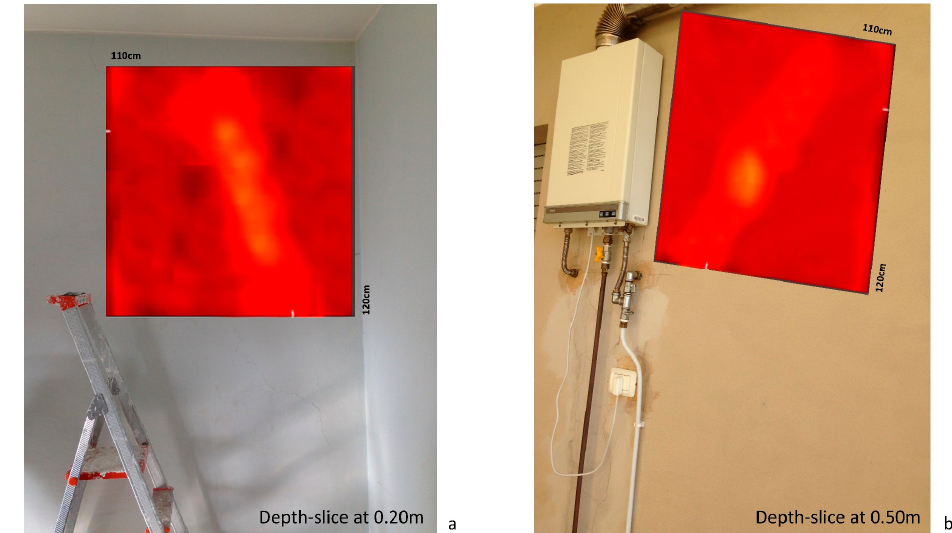
Figure 8. ( a ) The depth-slice at 0.2 m inside the masonry, revealing its inner geometry; ( b ) The depth- slice at 0.5 m of the same crack in the wall from the balcony.